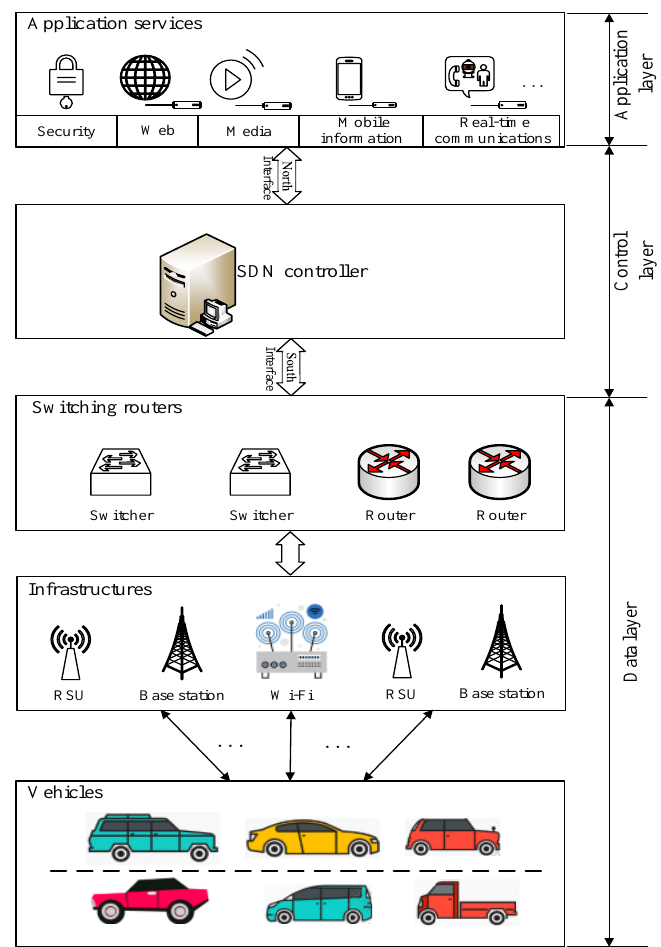
Figure 1. SDN-based vehicle network architecture.